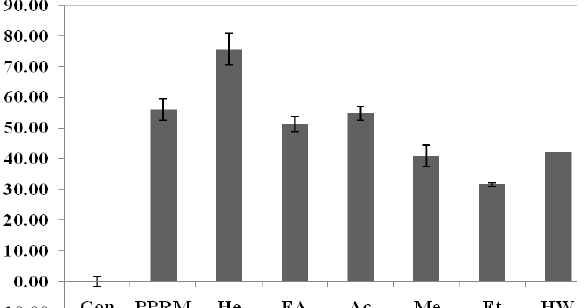
Figure 3. Elastase inhibitory activities in various solvent extracts of C.yabunikkei leaves (0.5 mg/mL) and Phospharamidon (PPRM, 0.5 mg/mL), He; hexane, EA; ethylacetate, Ac; acetone, Me; methanol, Et; ethanol, HW; hot water extract. Values were the mean ± standard deviation ( n = 3).